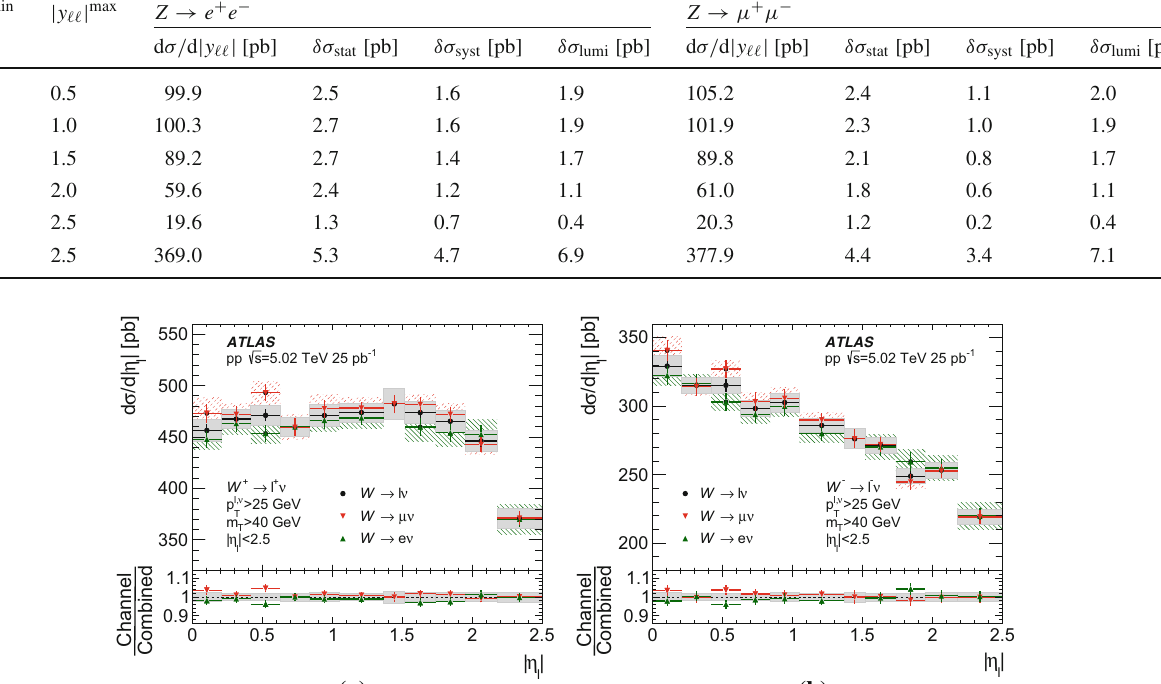
Table 5 Measured fiducial Z → (cid:5) + (cid:5) − differential and integrated cross sections for electron and muon channels